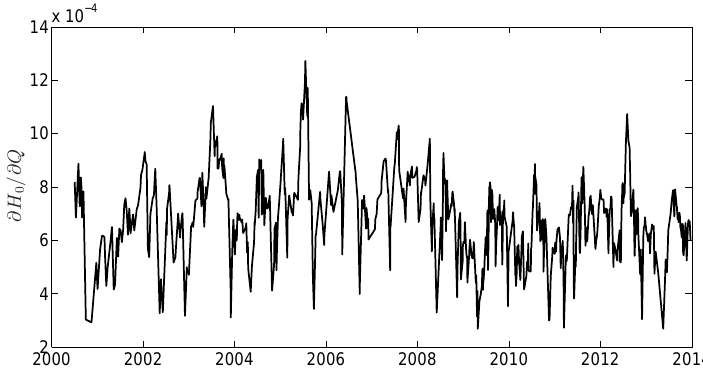
Figure 13. The time variable sensitivity of estimated H 0 to discharge observation ∂ H 0 / ∂ Q